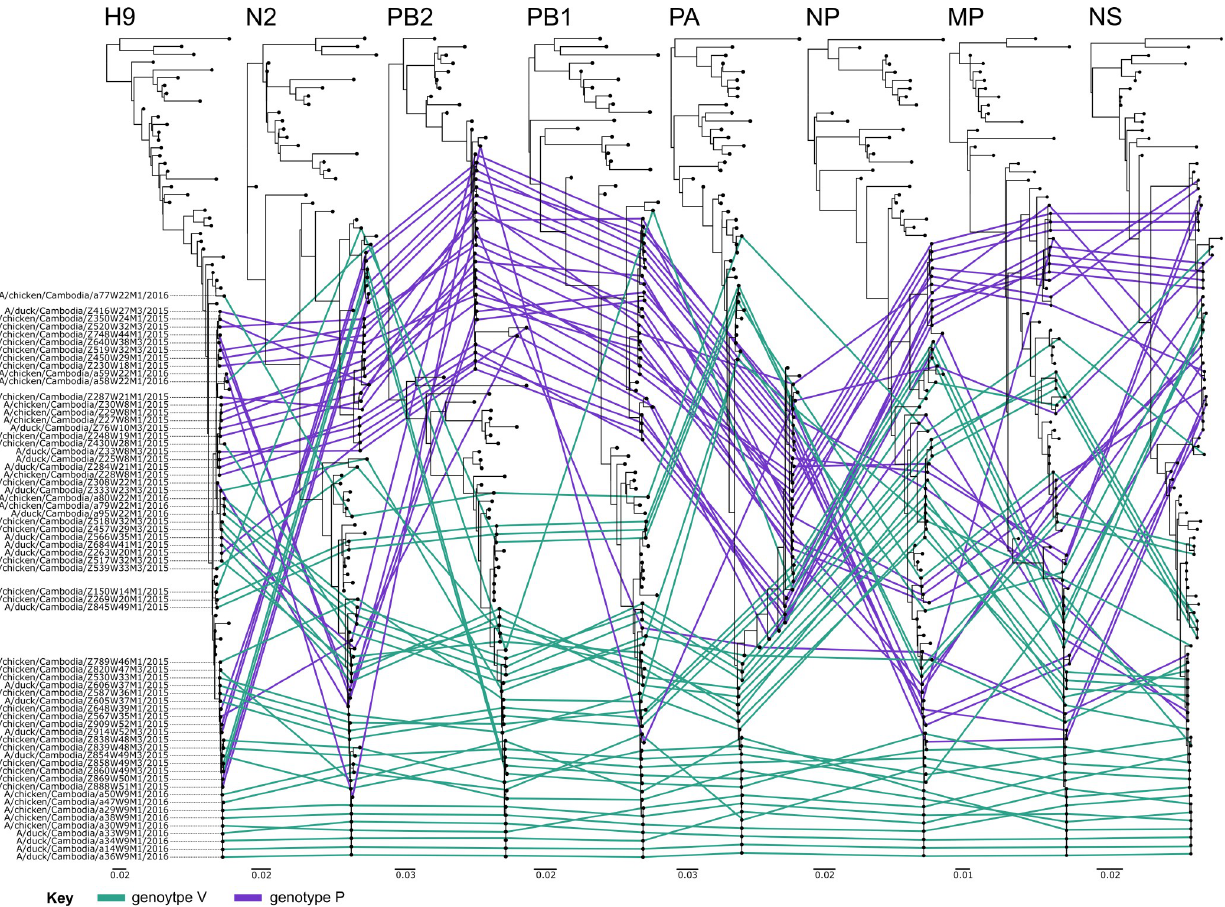
Fig 3. Phylogenetic congruency of Cambodian A(H9N2) viruses. ML trees were produced for all genomic segments using all Cambodian A(H9N2) viruses detected from 2015 to 2016 and key reference viruses. The phylogenies of the Cambodian viruses have been linked across all eight segments and colour coded according to viral genotype, genotype P viruses are shown in purple and genotype V in green. Viral designations are listed on the left hand side of the HA phylogeny. Incongruence is demonstrated by deviations in topology across the segments and can indicate viral reassortment has occurred. Scale bars are shown below each phylogeny and indicate the number of nucleotide substitutions per